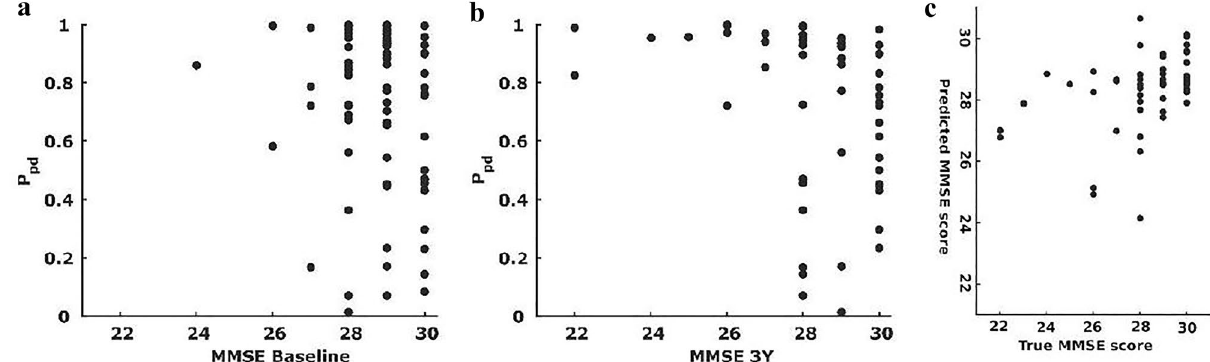
Figure 4. ( a ) MMSE baseline plotted against P PD at baseline for 75 patients. Against baseline (r = −0.09), ( b ) MMSE3Y plotted against P PD for 54 patients (r = −0.41), ( c ) predicted MMSE3Y plotted against true MMSE3Y (r = 0.33). Each dot represents a single